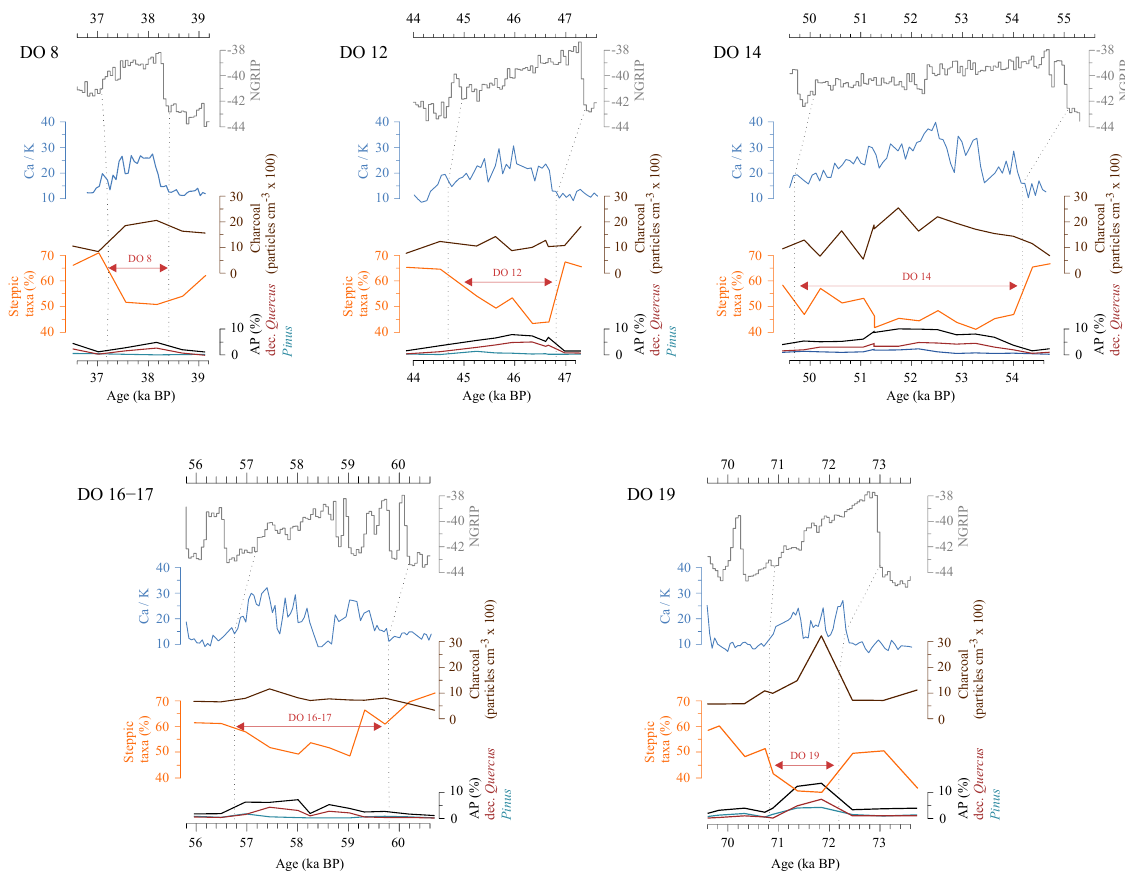
Figure 5. The most pronounced Dansgaard–Oeschger events DO 8, DO 12, DO 14, DO 16–17 and DO 19 are plotted in extra graphs, demon- strating a good correlation between the vegetation and environmental dynamics in eastern Anatolia and the δ 18 O-profile from the Greenland ice core sequence (NGRIP members, 2004); Ca / K ratio after Kwiecien et al. (2014); microscopic charcoal concentration (particles cm − 3 , this study); selected Lake Van arboreal pollen (AP, Pinus , deciduous Quercus in %, this study). The term “Steppic taxa” includes only major dry-adapted plants such as Chenopodiaceae and Artemisia